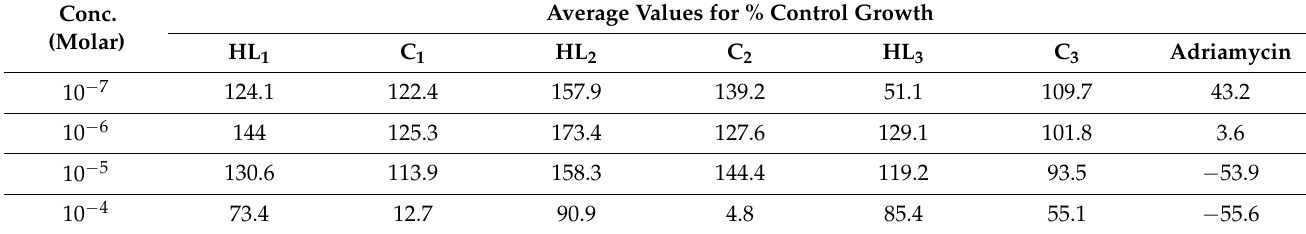
Figure 4. Growth curve for human ovarian cancer cell line OVCAR-3 for Schiff bases and their Ni(II) complexes. Table 10. Preliminary in vitro anticancer screening data of Schiff bases (HL 1 –HL 3 ) and their com- plexes (C 1 –C 3